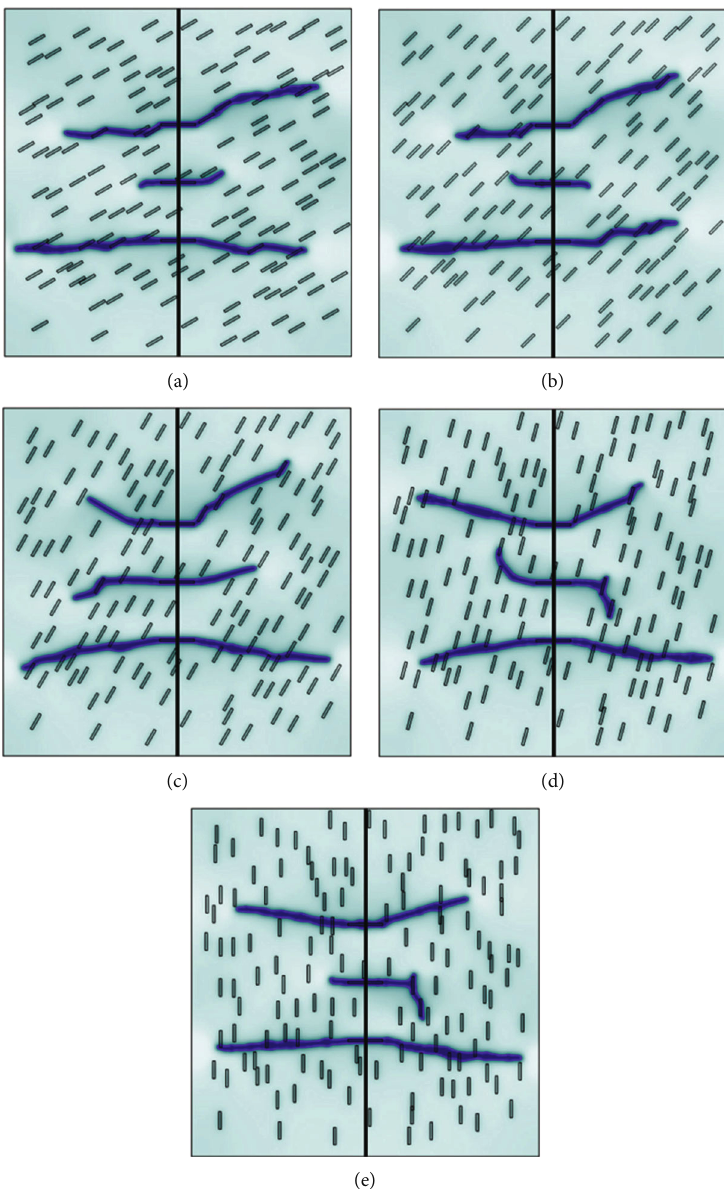
Figure 7: Fracture network morphology at di ff erent natural fracture orientations. (a) θ = 30 ° , (b) θ = 45 ° , (c) θ = 60 ° , (d) θ = 75 ° , and (e) θ = 90 °